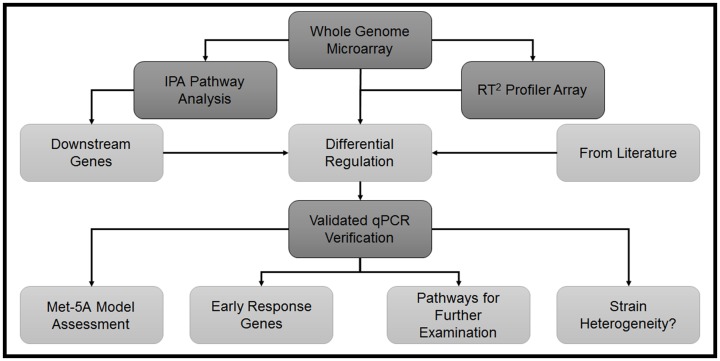
Flow chart demonstrating the experimental approach.Experimental steps are shown in dark grey and analysis and experimental questions are shown in light grey. IPA = Ingenuity Pathway Analysis.